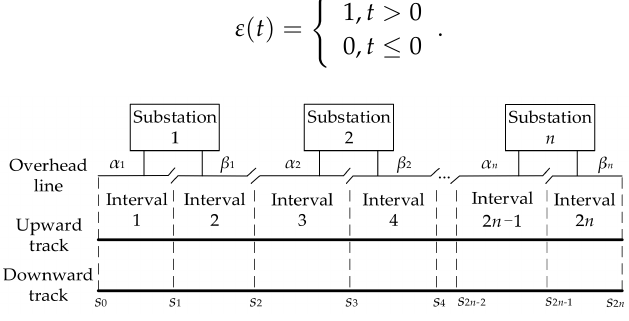
Figure 1. Schematic diagram of running line.